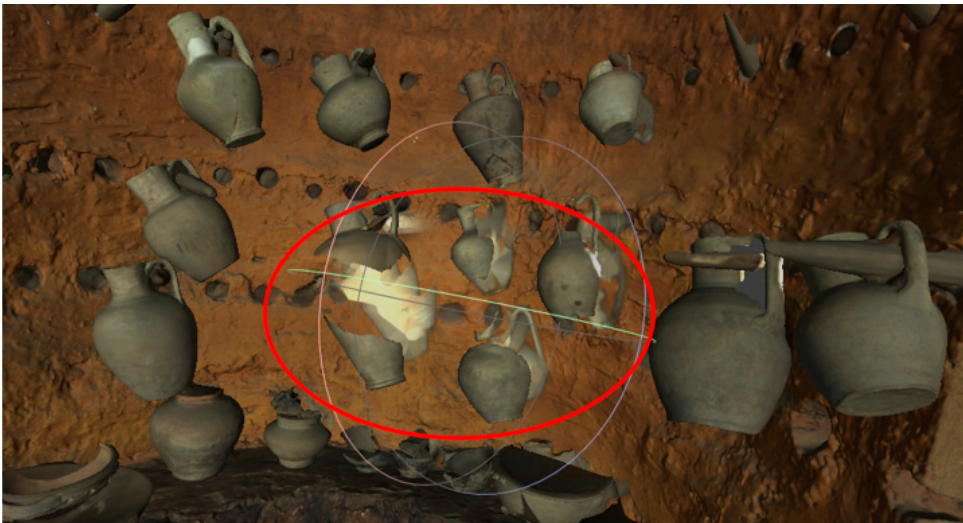
Figure 14. A 3D model with the texture of objects inside the furnace.